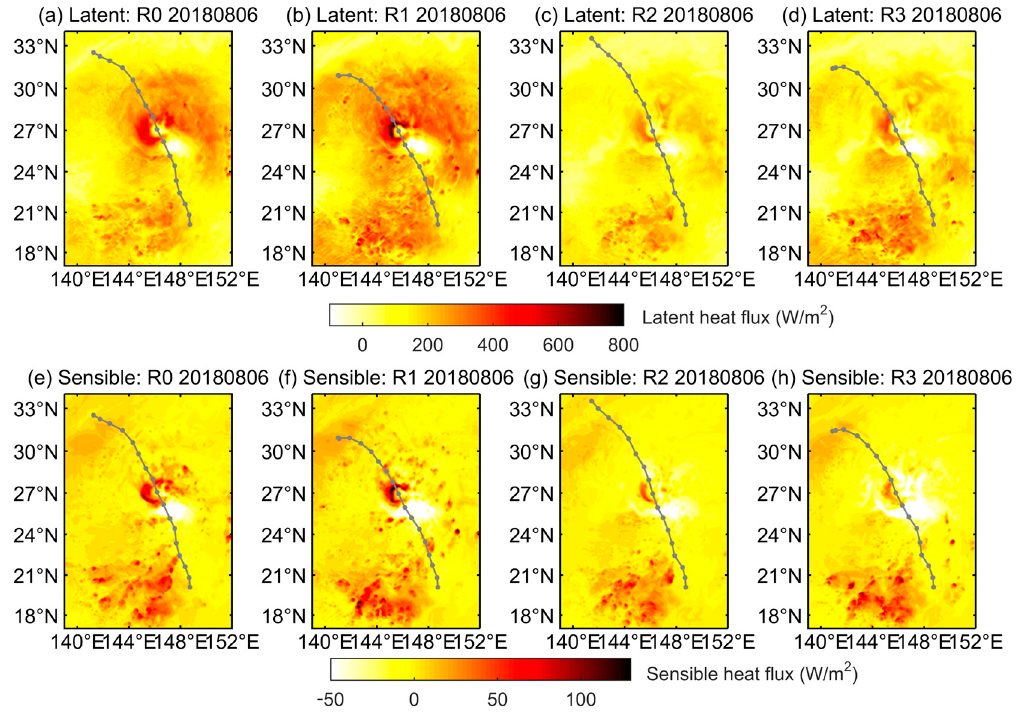
Figure 13. Distributions of heat fluxes for Shanshan. ( a – d ) Distributions of modeled latent heat fluxes for 6 August 2018 in R0, R1, R2, and R3; ( e – h ) distributions of modeled sensible heat fluxes for 6 August 2018 in R0, R1, R2, and R3. Grey lines are the simulated tracks for Shanshan. See Section 3.1 for details of the simulations.